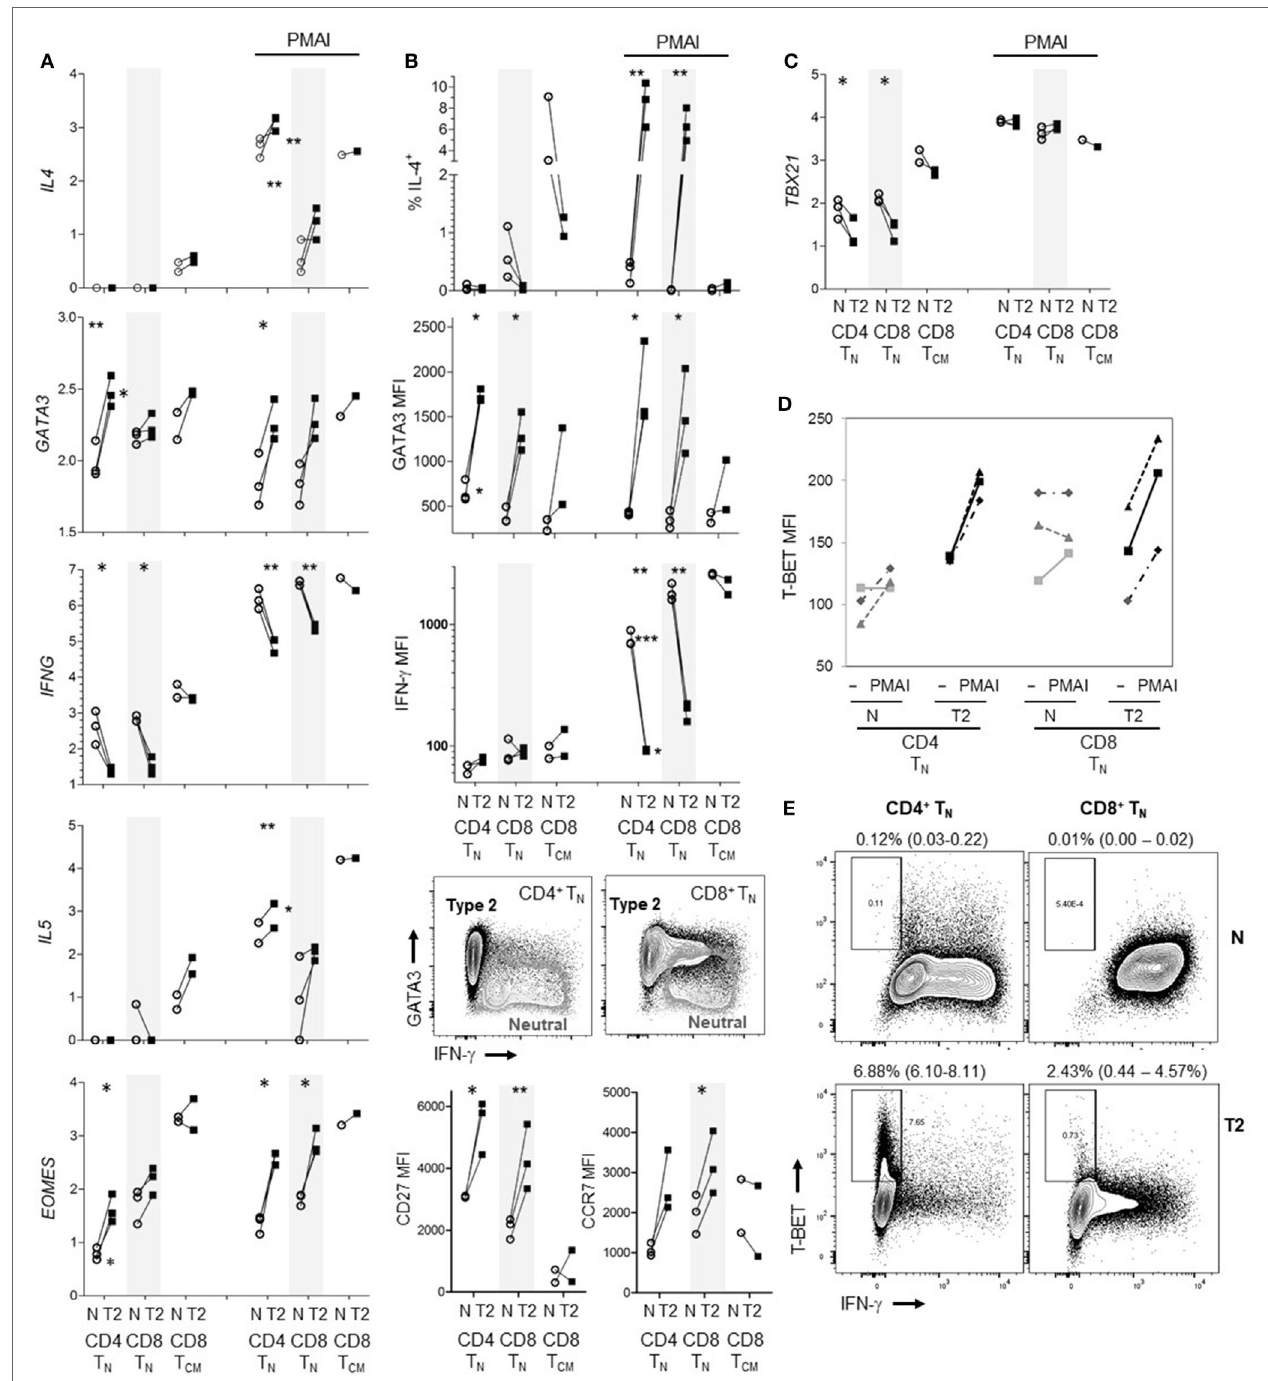
FigUre 6 | Effects of type-2 (T2) conditions on differentiation of CD4 + T N versus CD8 + T N and T CM following activation in vitro . Sorted T N subsets from three donors and CD8 + T CM from two donors were activated in neutral (N) or T2 conditions for 5 days then rested for 3 days. T2 media also contained anti-IL-12 mAb. (a) Log 10 mRNA expression relative to reference gene, with and without PMA and ionomycin (PMAI) restimulation. Lines join results for N and T2-primed subsets from the same donor. p -Values are indicated for pairwise comparisons of neutral versus T2 conditions for each subset, as well as for CD4 + versus CD8 + T N for each priming condition (*** p < 0.001, ** p < 0.01, and * p < 0.05). (b) Intracellular and cell surface protein detection by flow cytometry for each subset, presented as in (a) . Representative FACS plots show PMAI restimulated cells from one donor, overlaying profiles for N versus T2-primed cells. (c) Log 10 TBX21 mRNA expression, presented as in (a) . (D) Effects of PMAI restimulation on T-BET mean fluorescence intensity (MFI) are compared for each T N cell subset and priming condition. (e) Representative FACS plots of IFN- γ versus T-BET staining following PMAI restimulation for each subset and condition for one donor, showing average (range)% T-BET + IFN- γ − for three